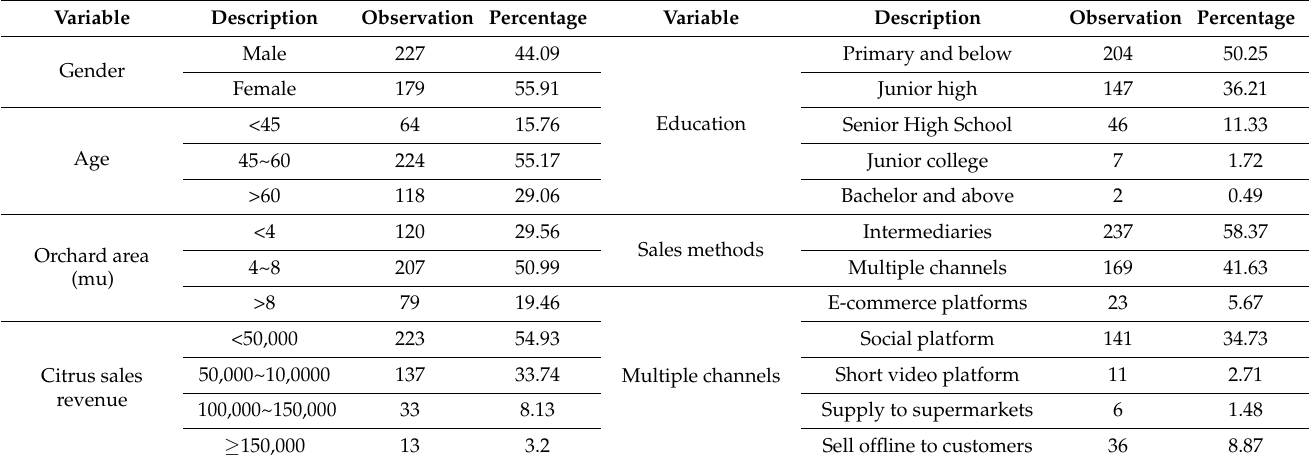
Table 1. The distribution of the